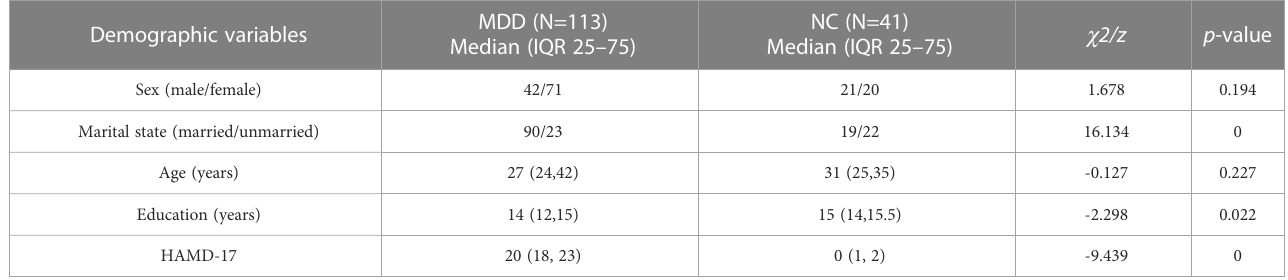
TABLE 1 Comparison of demographic data between the MDD group and HC